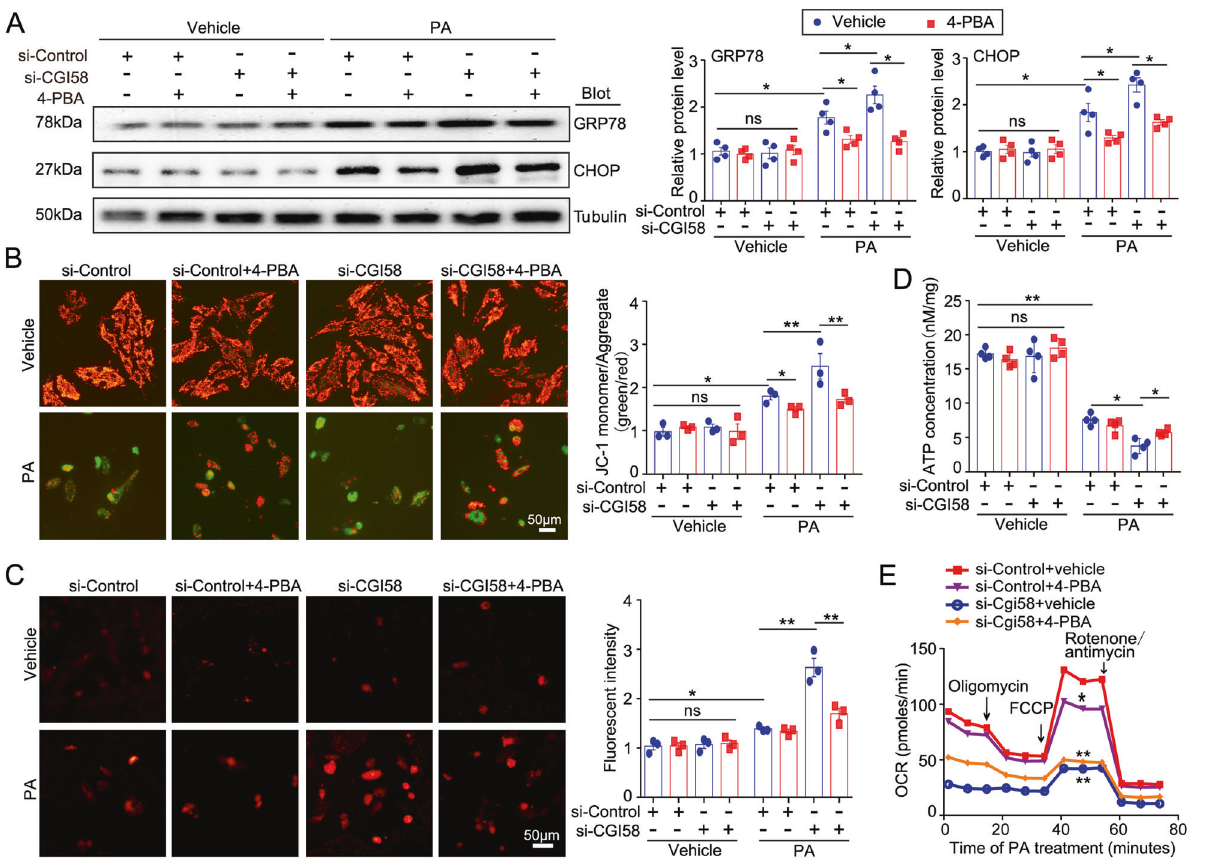
Fig. 6 ER stress inhibitor 4-PBA attenuates ROS generation and mitochondrial dysfunction in CGI-58 knockdown NRCMs. A Western blot analysis of GRP78 and CHOP protein levels ( n = 4). B JC-1 staining of mitochondrial membrane potential (left), and the ratio of JC-1 in the polarized or aggregate form (red) to the depolarized or monomer form (green) (right, n = 3). C The ROS level in NRCMs was evaluated with MitoSOX (0.5 mM; left), and the quanti fi cation of MitoSOX fl uorescence from 100 cells of each independent experiment (right, n = 3). D The ATP content in NRCMs ( n = 4). E Cardiomyocyte OCR changes examined by Seahorse XF 24 extracellular analyzer. * P < 0.05, ** P <